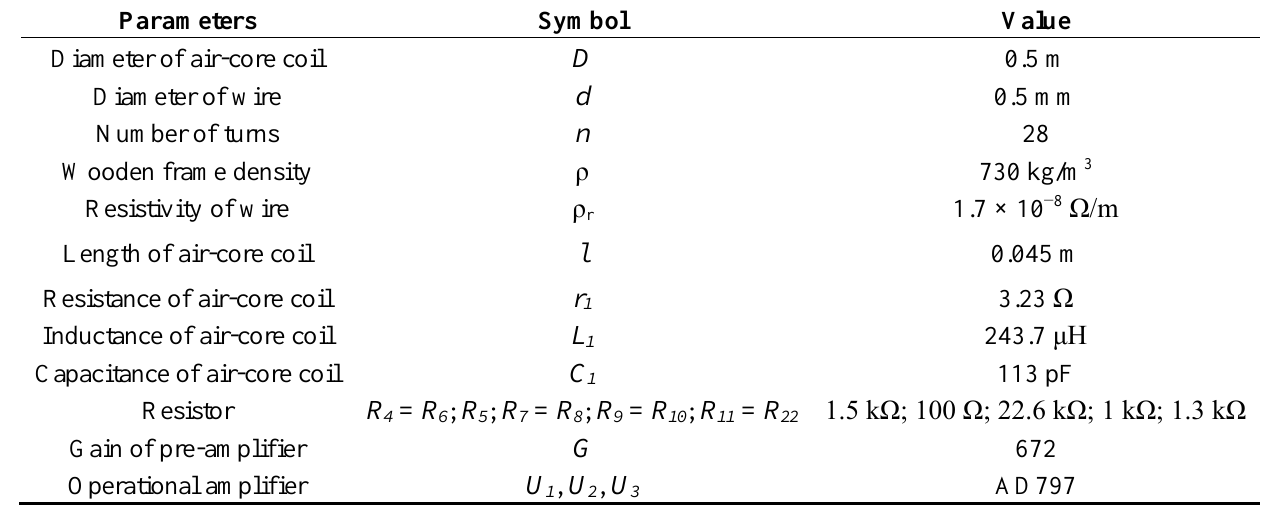
Table 1. Fabricated parameters of